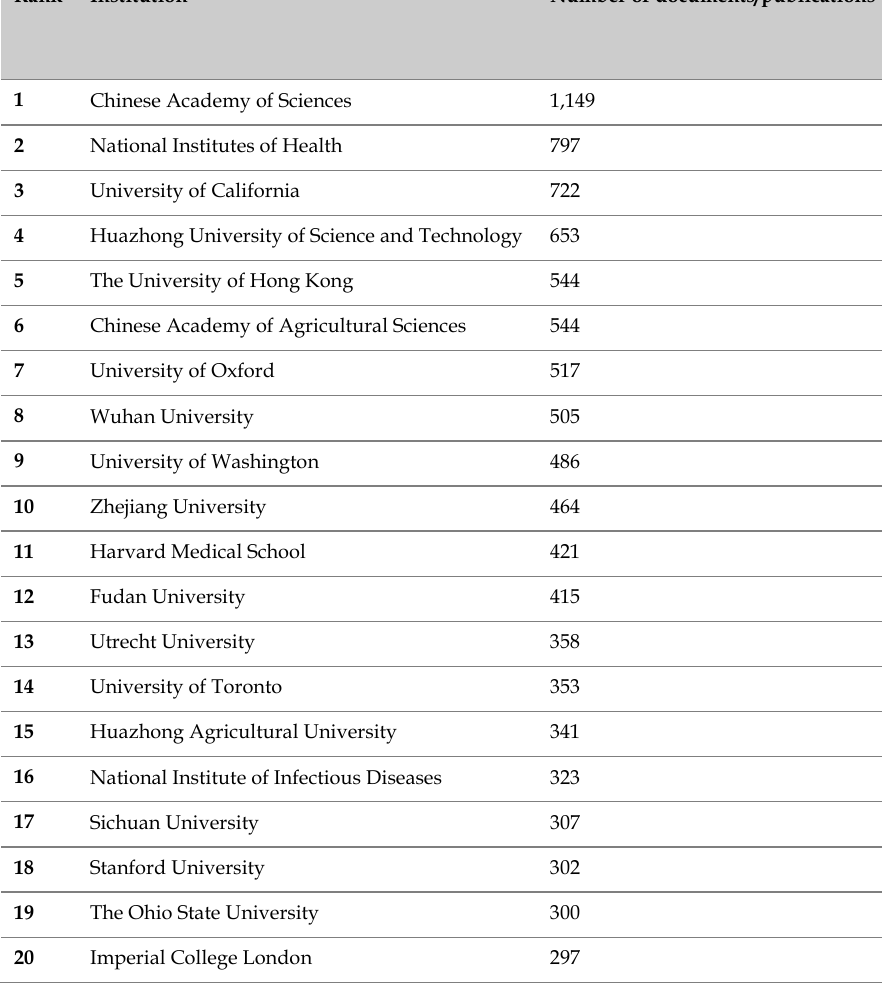
Table 1 The top 20 institutions participating in COVID-19 research